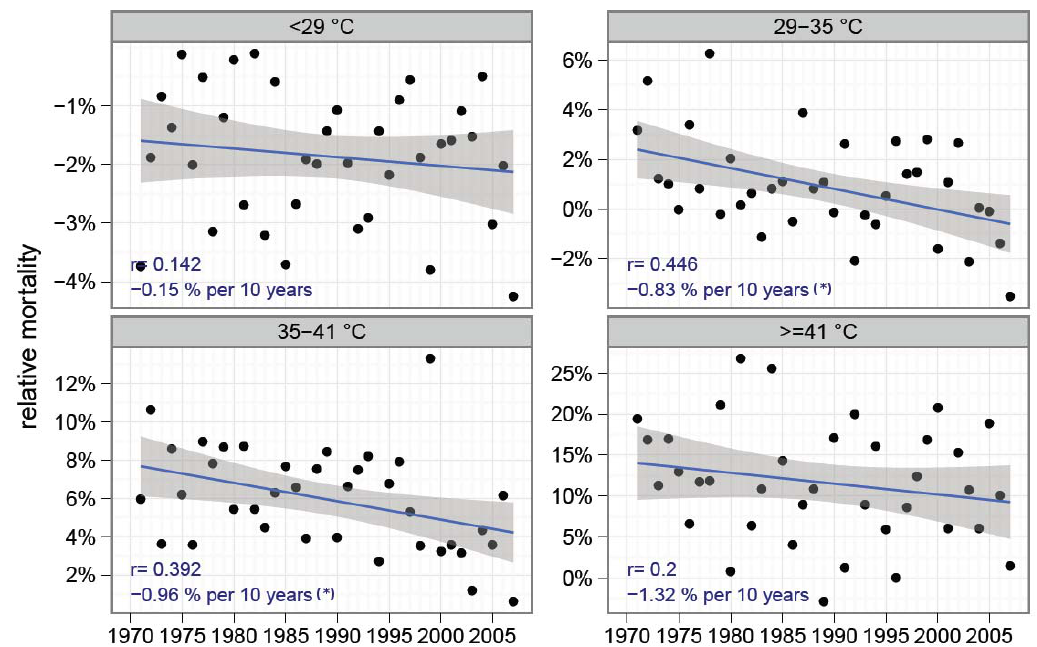
Figure 2. Time series of mean relative mortality for different grades of thermo- physiological stress. Additionally, a linear regression line with CI is included. The parameters of the regression (correlation coefficient and slope) are shown in the lower left corner of each figure. Significant trends at 95% level are marked by (*). Due to the large differences between the thermal stress levels, the y-axes are scaled